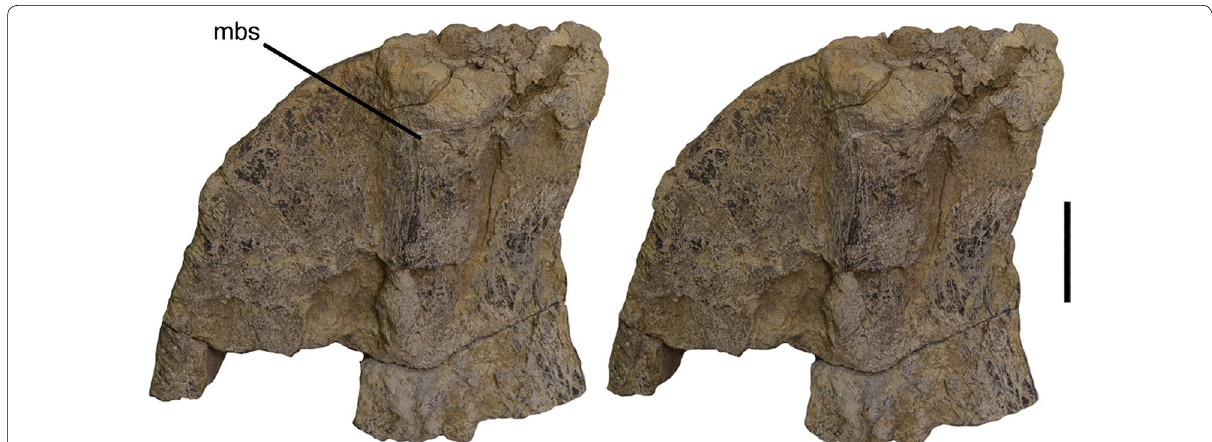
Fig. 19 Stereophotograph of the medial side of the postacetabular process of the ilium of Schleitheimia , PIMUZ A/III 550, showing the unusual development of the medial brevis shelf (mbs). Posterior is to the top